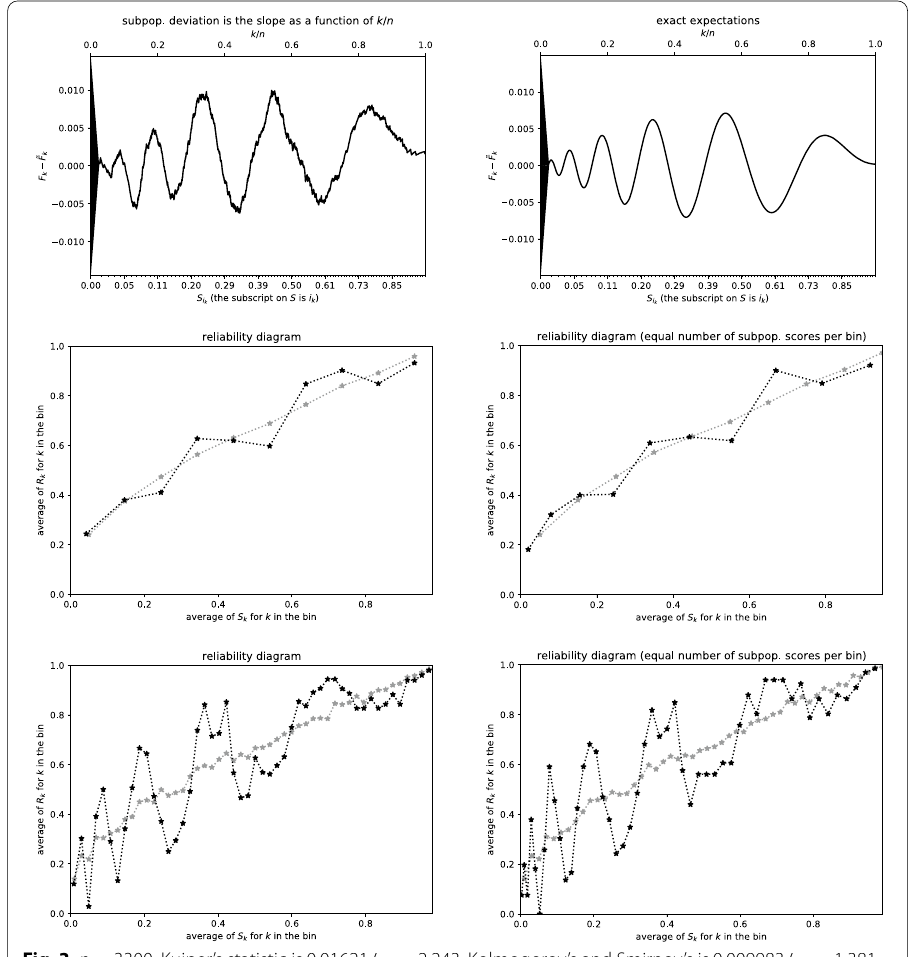
Fig. 3 n = 3300; Kuiper’s statistic is 0.01621 /σ = 2.243 , Kolmogorov’s and Smirnov’s is 0.009983 /σ = 1.381 . Figure 4 displays the ground-truth reliability diagram. Distinguishing random fluctuations from real variations is difficult in the reliability diagrams with 50 bins each. The reliability diagrams that each have only 10 bins could be misleading, as the depicted variations in the subpopulation’s outcomes are grossly lower than the actual underlying variations as a function of score. The plot of cumulative deviation is far from perfect, yet captures the exact expectations quite well qualitatively and tolerably well quantitatively. The scalar summary statistics have trouble detecting the significant deviation of the subpopulation from the full population. This illustrates a blind spot in the Kolmogorov–Smirnov and Kuiper statistics, namely, they have a hard time detecting oscillatory discrepancies that average away upon summation. Neither the Kolmogorov-Smirnov metric nor the Kuiper metric is very sensitive to high-frequency deviations whose mean is